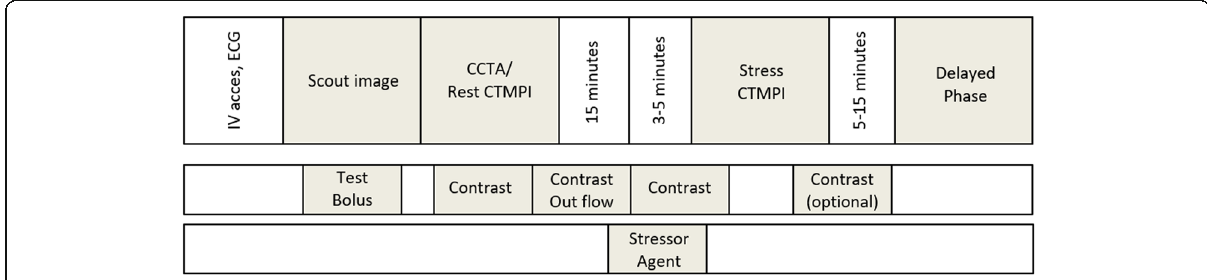
Fig. 3 Schematic representation of cardiac imaging protocol, including anatomical evaluation using coronary CT angiography (or rest perfusion in case of static perfusion imaging) and functional evaluation using rest/stress CT-myocardial perfusion imaging. An optional acquisition can be used for the detection of myocardial scarring using delayed phase